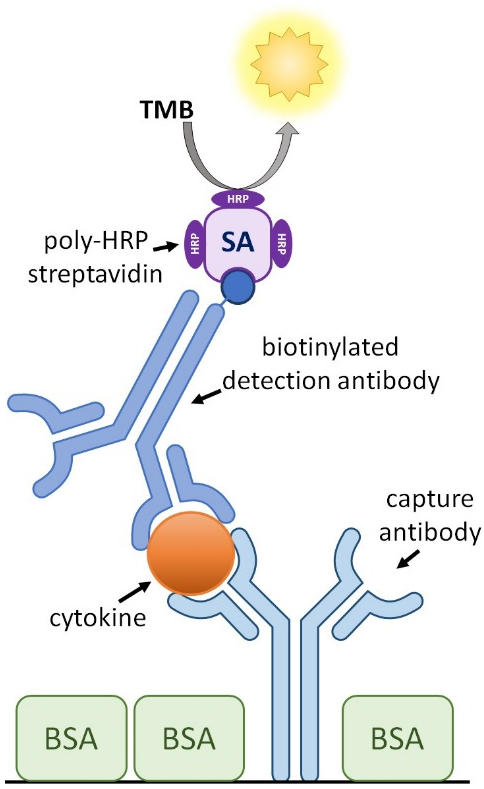
Figure 1. Schematic presentation of the cytokine capture ELISA. Both the capture and the detection antibodies are specific for an individual chicken cytokine protein. BSA—bovine serum albumin, SA—streptavidin, HRP—horse radish peroxidase, TMB—3,3’,5,5’-Tetramethylbenzidine.